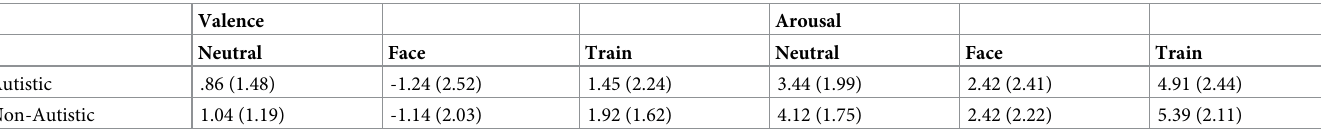
Table 2. Mean (standard deviation) ratings of valence and arousal for Experiment 2.